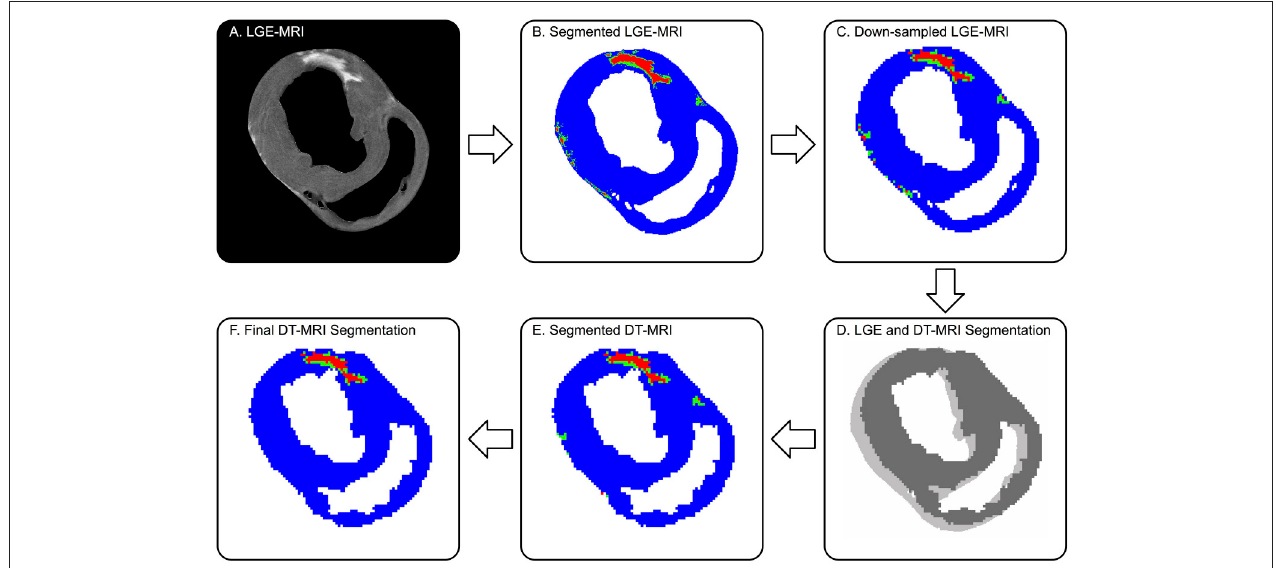
FIGURE 1 | Defining remote (blue), borderzone (green), and infarcted (red) myocardium on DT-MRI from co-registered LGE MRI. (A) Original high-resolution LGE MRI shows a distinctly bright focal infarct. (B) The threshold segmented LGE image is (C) down-sampled to match the DT-MRI resolution, then (D) co-registered to DT-MRI via 2D cross-correlation. (E) The registered LGE segmentation mask is superimposed onto the corresponding myocardial mask of the DT-MRI data. (F) Final DT-MRI segmentation refined by excluding islands of high signal intensity consisting of three or less voxels (9 mm 3 ) and removing BZ signal intensities greater than three voxels (3mm) away from infarct. Note, the LGE to DT-MRI registration required a single pixel-level